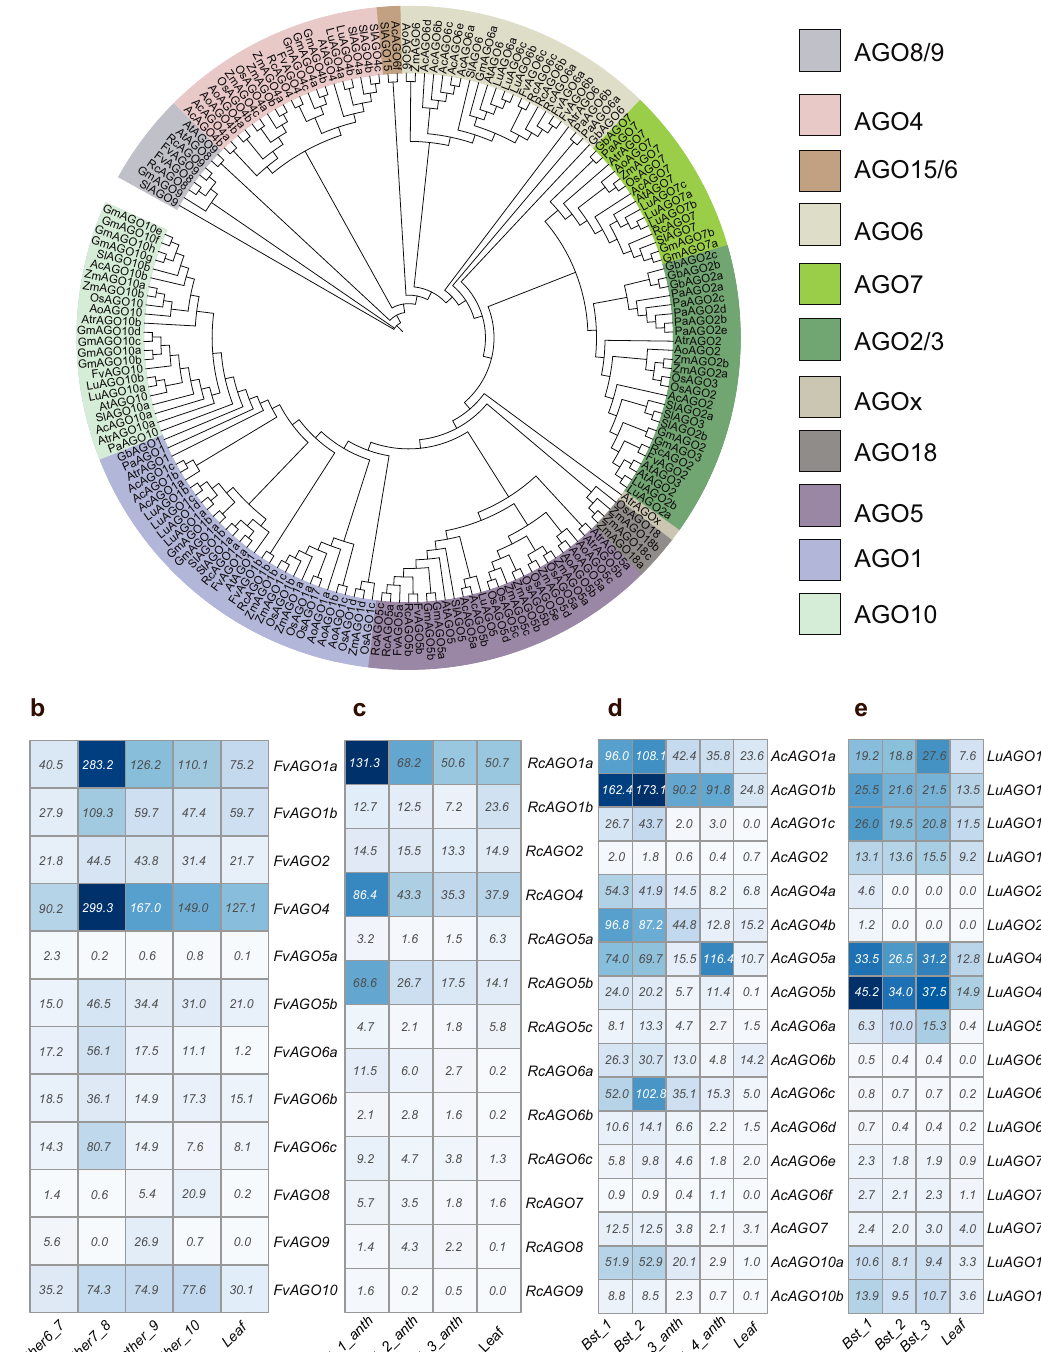
Fig. 5 Characterization of AGO gene family members in wild strawberry, rose, columbine, fl ax, and other representative species from gymnosperms, eudicots, and monocots. a Phylogenetic tree of Argonaute protein family members encoded in the genomes of plant species, with two-letter pre fi x indicating the source genome: wild strawberry (Fv), rose (Rc), columbine (Ac), fl ax (Lu), Norway spruce (Pa), and ginko (Gb) identi fi ed in this study along with other seven representative species — Amborella (Atr), soybean (Gm), tomato (Sl), Arabidopsis (At), asparagus (Ao), maize (Zm), and rice (Os). Abundance pro fi le of genes encoding AGO family members in b wild strawberry, c in rose, d in columbine, and e in fl ax. Bst indicates the bud stage, anth indicates the anther. Source data underlying Fig. 5b – e are provided as a Source Data fi le.